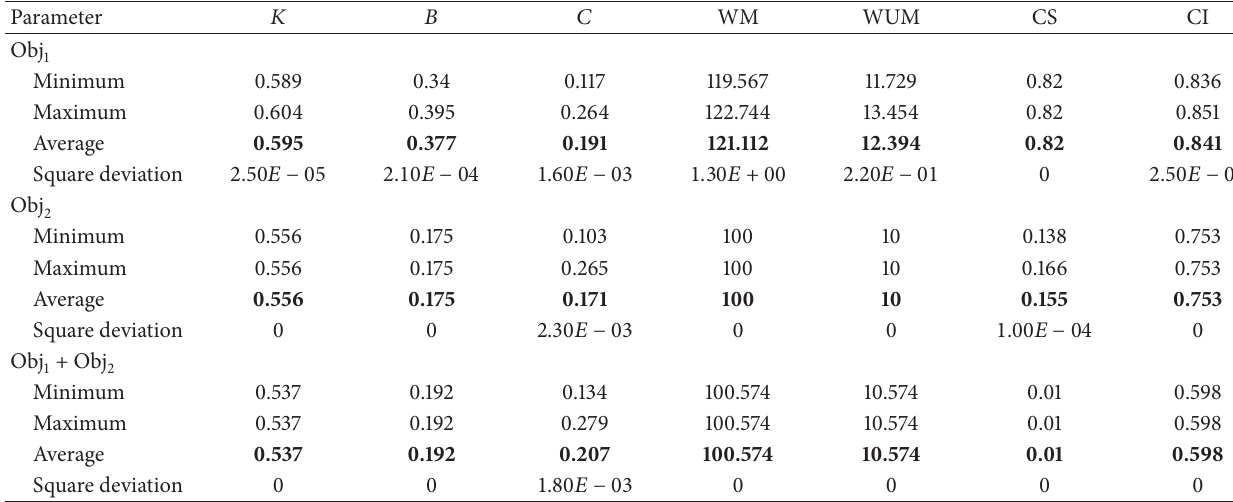
Table 8: Characteristics of the optimization results.